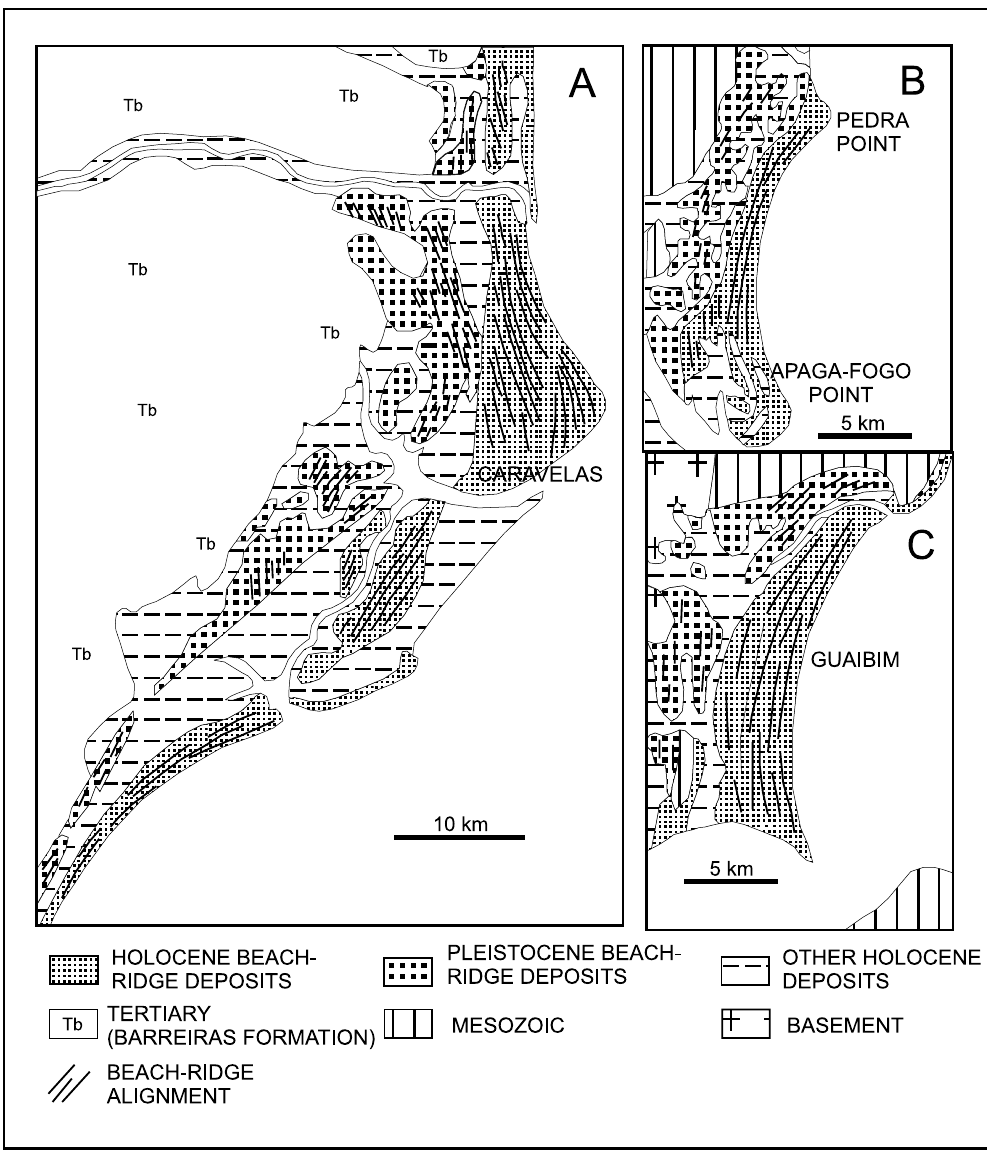
Fig. 9 – Simplified geological maps of some coastal plains alongside the coast of the State of Bahia illustrating the persistence of the sediment dispersion and accumulation patterns during the Quaternary Period (modified from Martin et al.